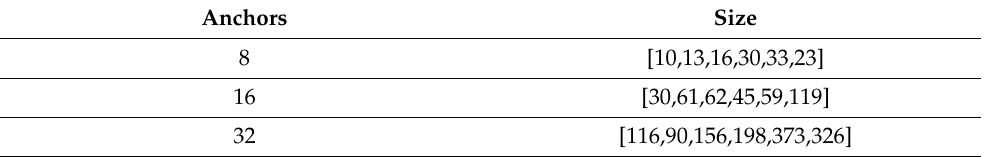
Table 1. The anchor setting of Yolov5. Anchors